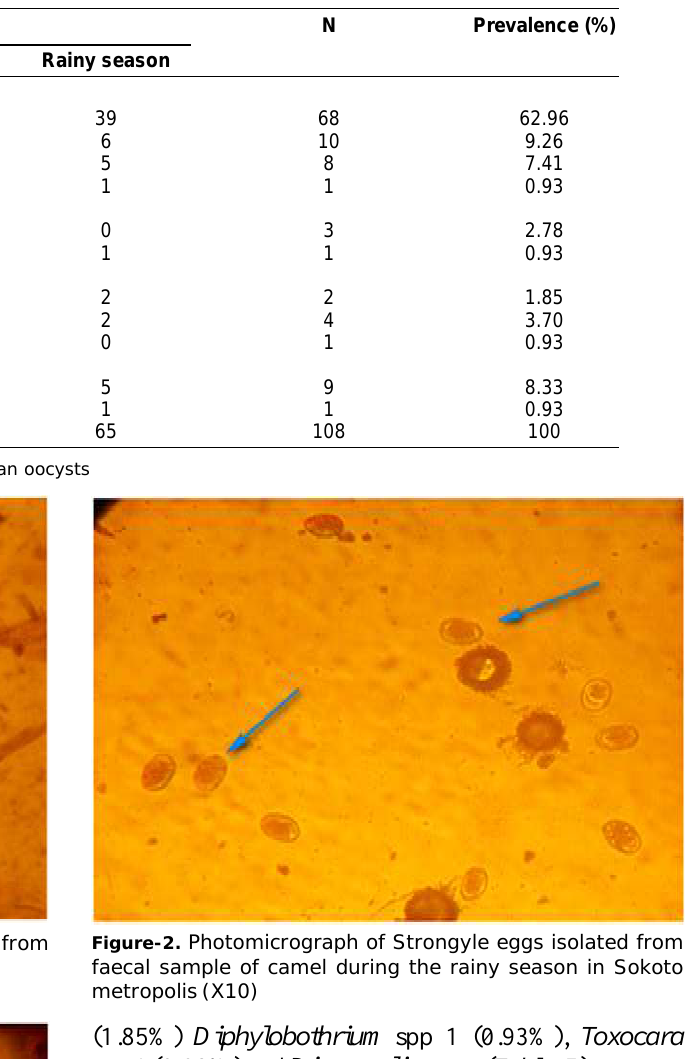
Table-5. Prevalence of gastrointestinal parasites (egg/oocyst) in faeces of camels in Sokoto metropolis. Parasites